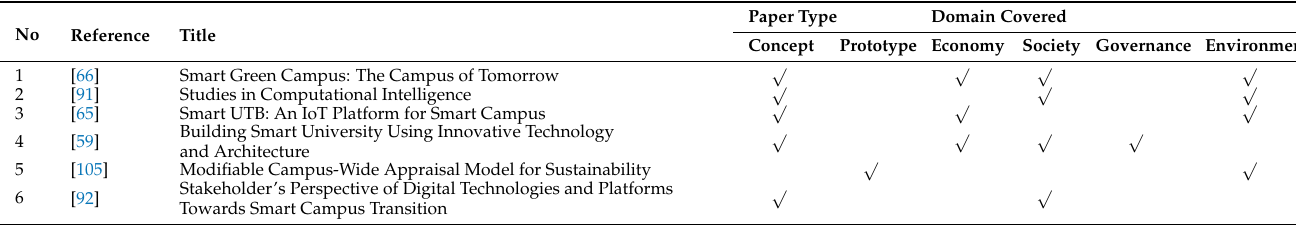
Table A1. Reviewed articles, paper types, and